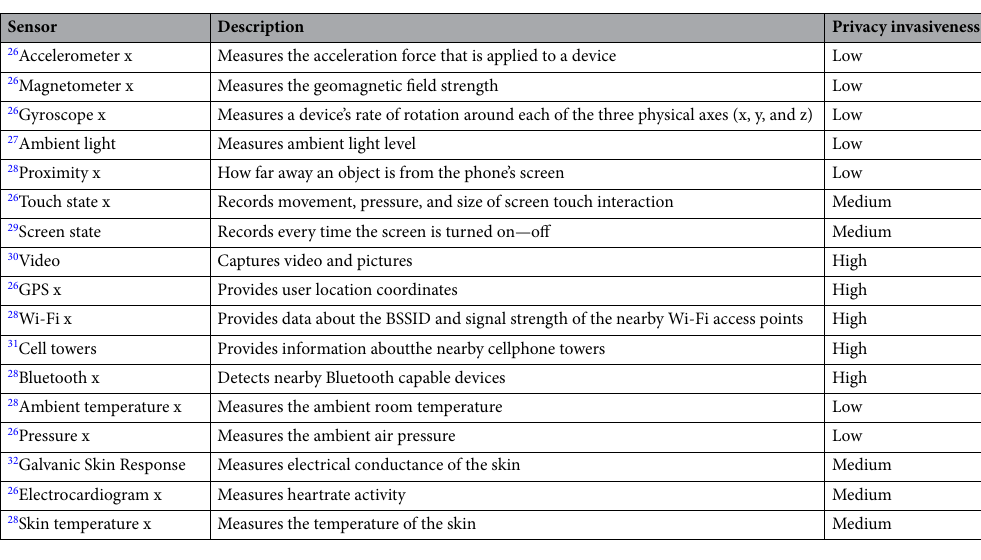
Table 1. Sensing capabilities commonly found in wearable devices.